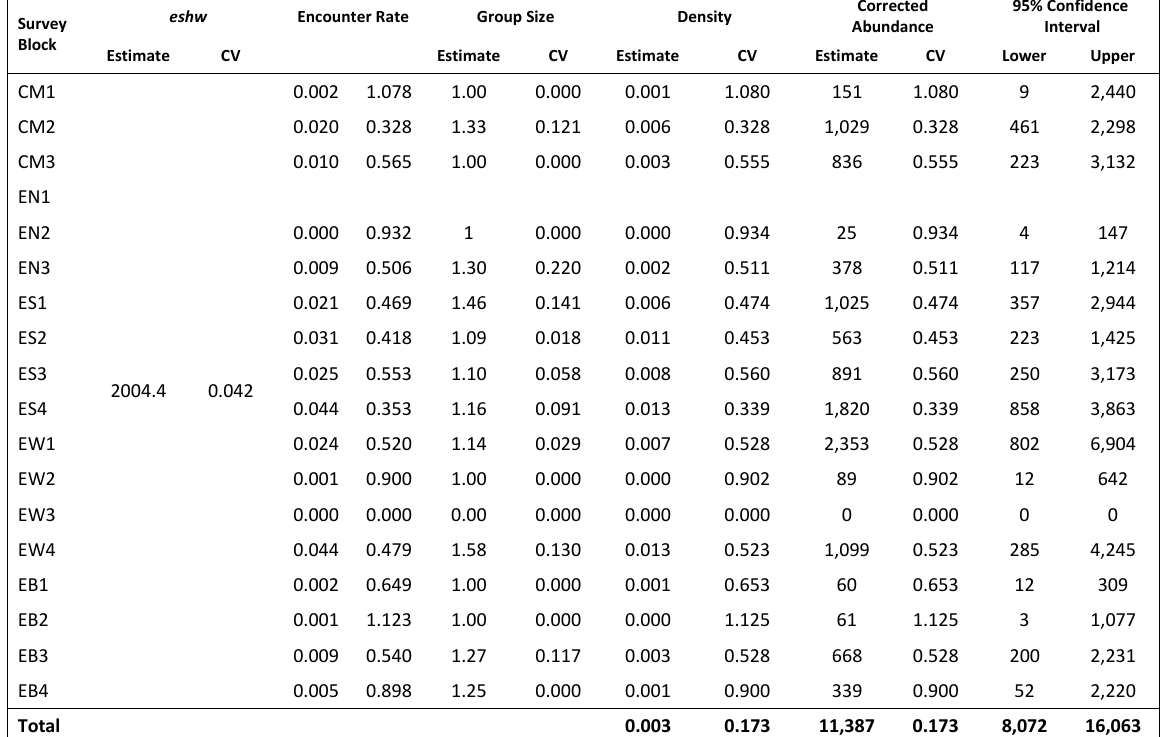
Table 6. Estimated density and abundance of fin whales. The eshw (effective search half width (m)) was estimated for the entire study area. Encounter rate, group size, density, abundance, and upper and lower confidence limits were estimated by block and corrected for perception bias, with the estimated p